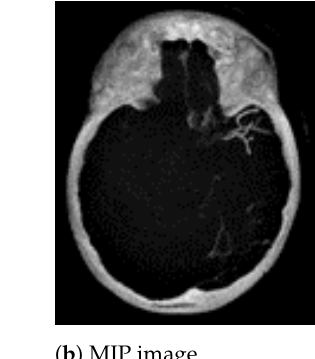
Figure 2. The images from ( a ) are stacked, and the maximum pixel value is extracted to generate the image in ( b ).